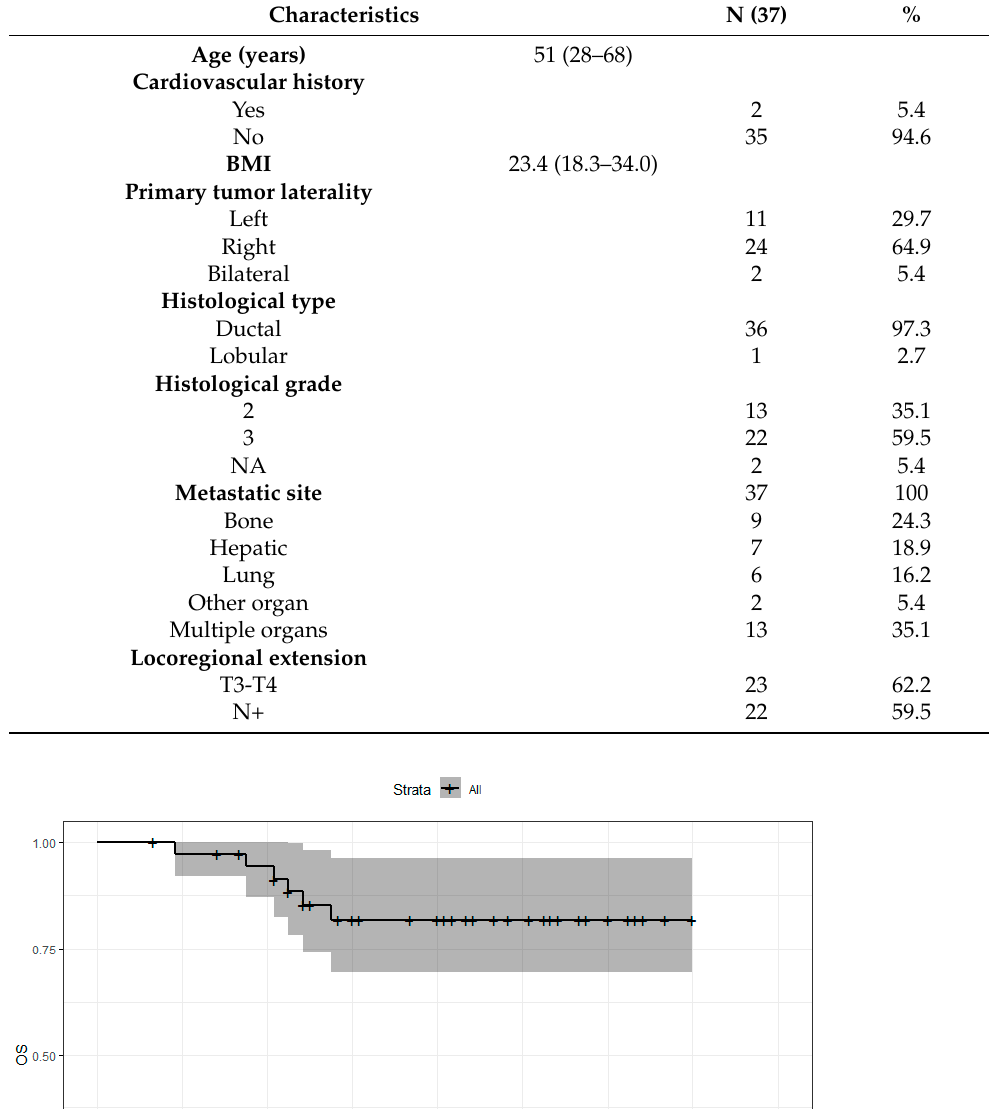
Table 2. Characteristics of the population with metastatic disease at the time of diagnosis.